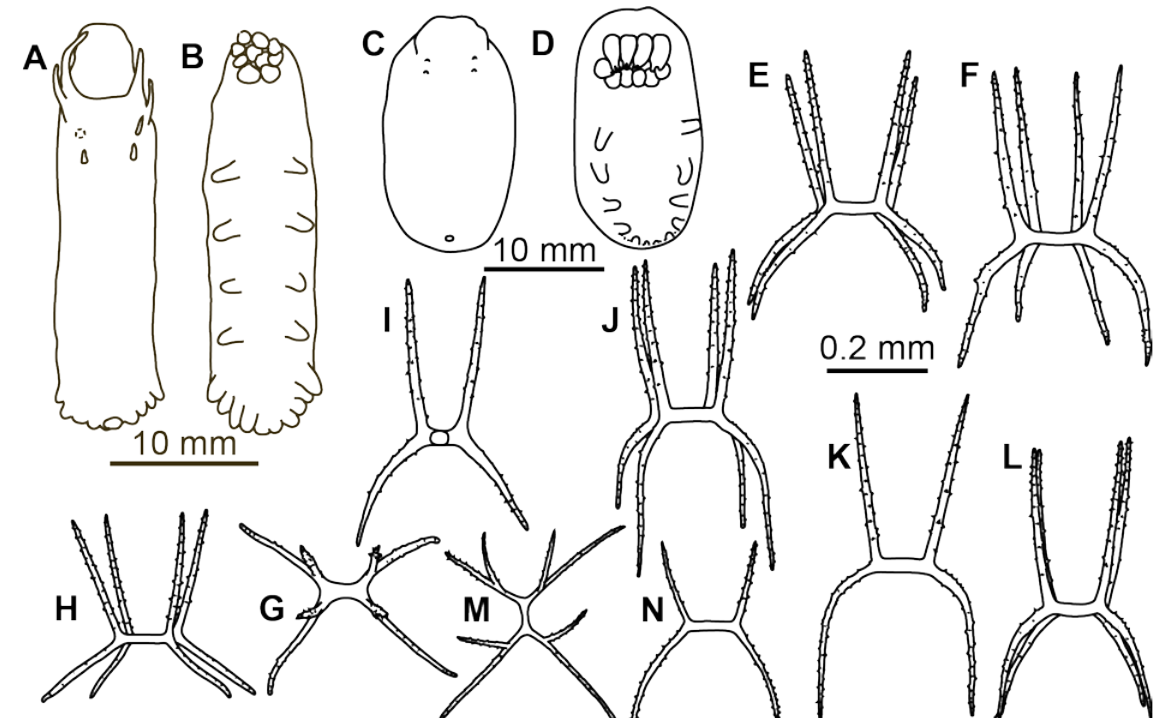
Figure 1. Peniagone dubia and P. minuta sp. nov. ( A , B ) P. dubia , dorsal and ventral view of specimen IORAS ECH01476; ( C – L ) P. minuta : ( C , D ) dorsal and ventral view of the holotype, dorsal ( E – L ) and ventral ( M , N ) ossicles, scale 0.2 mm, a pair of arms and apophyses omitted on ( I , K , N ).